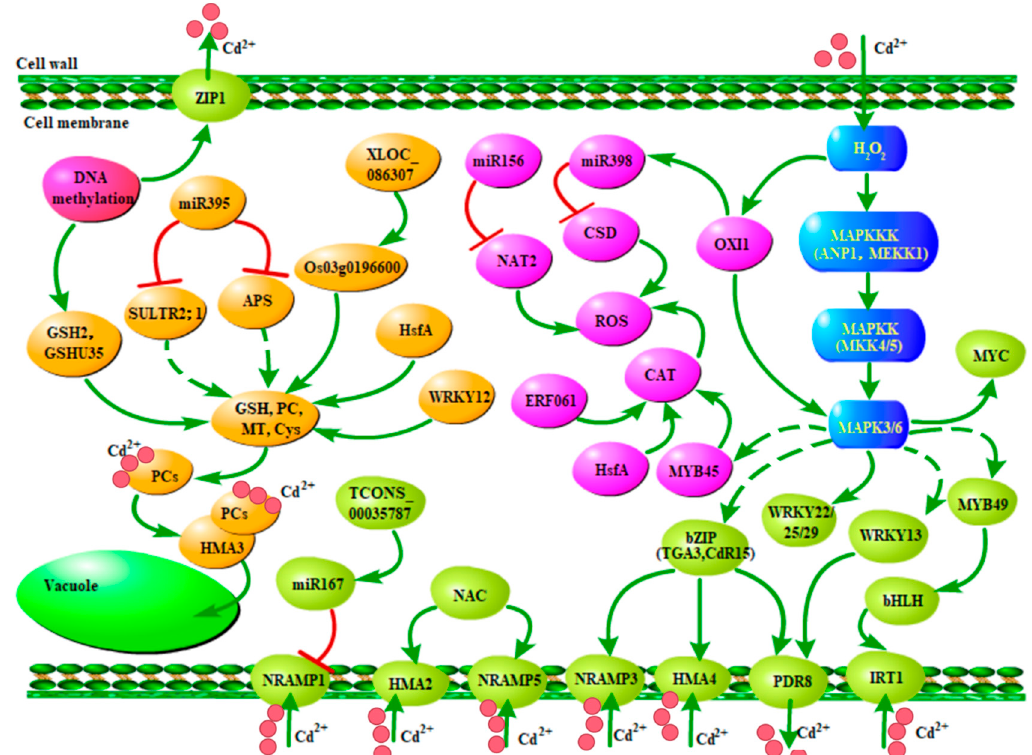
Figure 2. Overview of the transcriptional regulatory network in the response to Cd stress. As indicated in blue, H 2 O 2 acts as a signaling molecule activating MAPK cascades. Key factors including TFs and metal transporters involved in Cd transport and efflux are indicated in green. Key factors involved in Cd chelation into vacuoles are indicated in orange. Key factors involved in ROS scavenge are indicated in purple. Arrows show simultaneous effects in the pathway, while the nail shapes represent repression. Dashed lines denote links to be confirmed. Table 1. Genes involved in Cd uptake, transport, sequestration, and detoxification in plants.